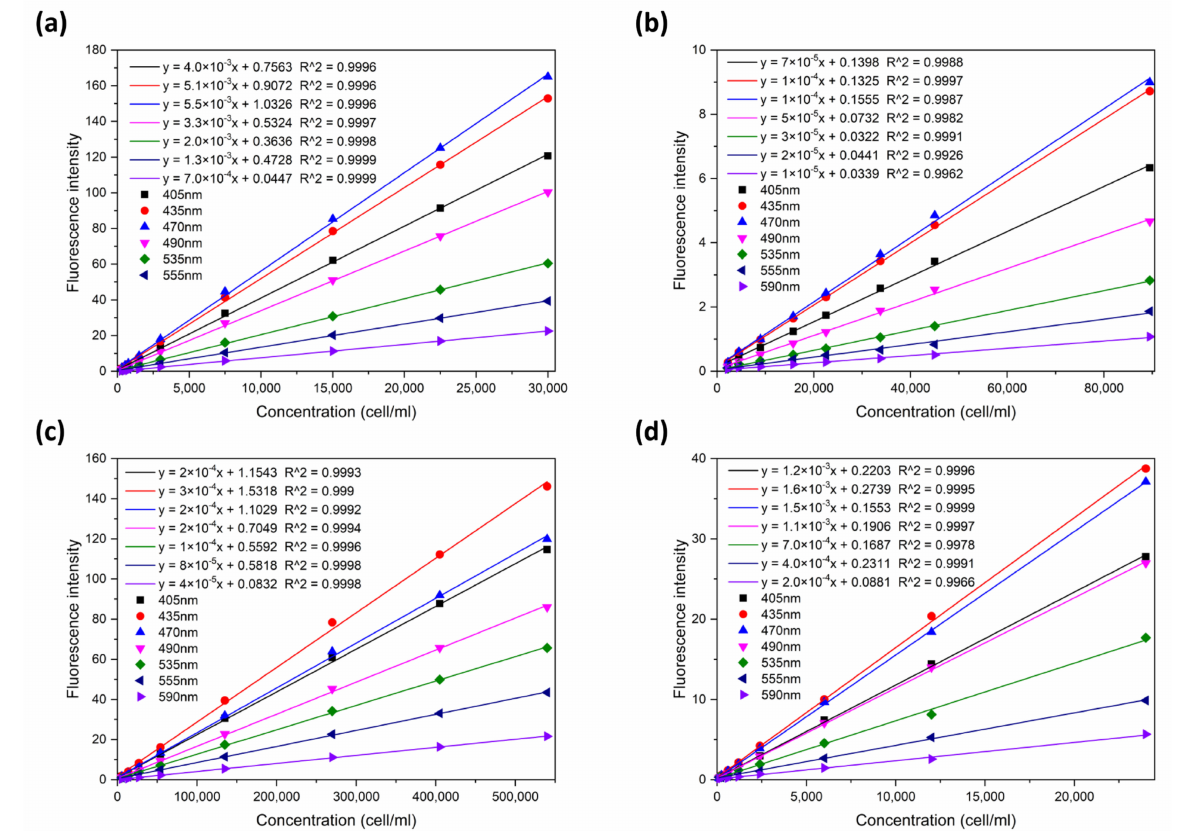
Figure 6. Linear function between fluorescence intensity and concentration at seven characteristic excitation wavelengths for four species of algae: ( a ) Amphidinium carterae (toxic algae); ( b ) Phaeocystis globose (toxic algae); ( c ) Skeletonema costatum (non-toxic algae); and ( d ) Prorocentrum donghaiensis (non-toxic algae). After confirming species, the norm spectrum was used to calculate the cell density by the model. With all designed concentration ratios, only the dominant species were targeted (Figure 7). The black line was fitted by standard concentration and the red circles indicate measured concentrations. In general, the red circles are quite close to the standard, especially at the initial part of the axis where the cell densities are below 5.35 × 10 4 cells/mL. More details of the results are shown in Table 7.